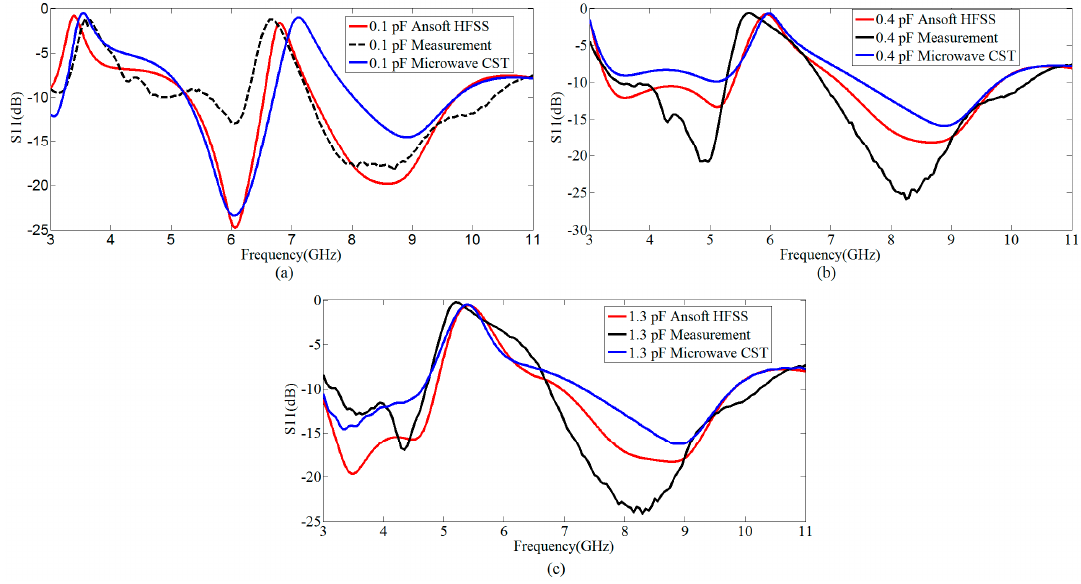
Figure 6. Simulated versus measured results of the proposed resonator based switchable UWB band ‐ notched antenna; ( a ) at 0.1 pF; ( b ) at 0.4 pF; ( c ) at 1.3 pF.